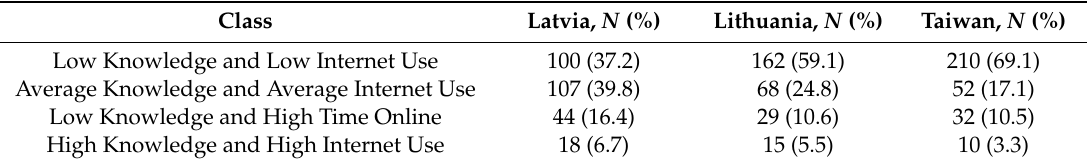
Table 4. Number of children from di ff erent data collection sites in each